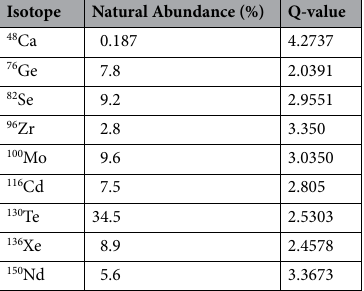
Table 1. A list of isotopes of interest and the Q-values for the neutrinoless double beta